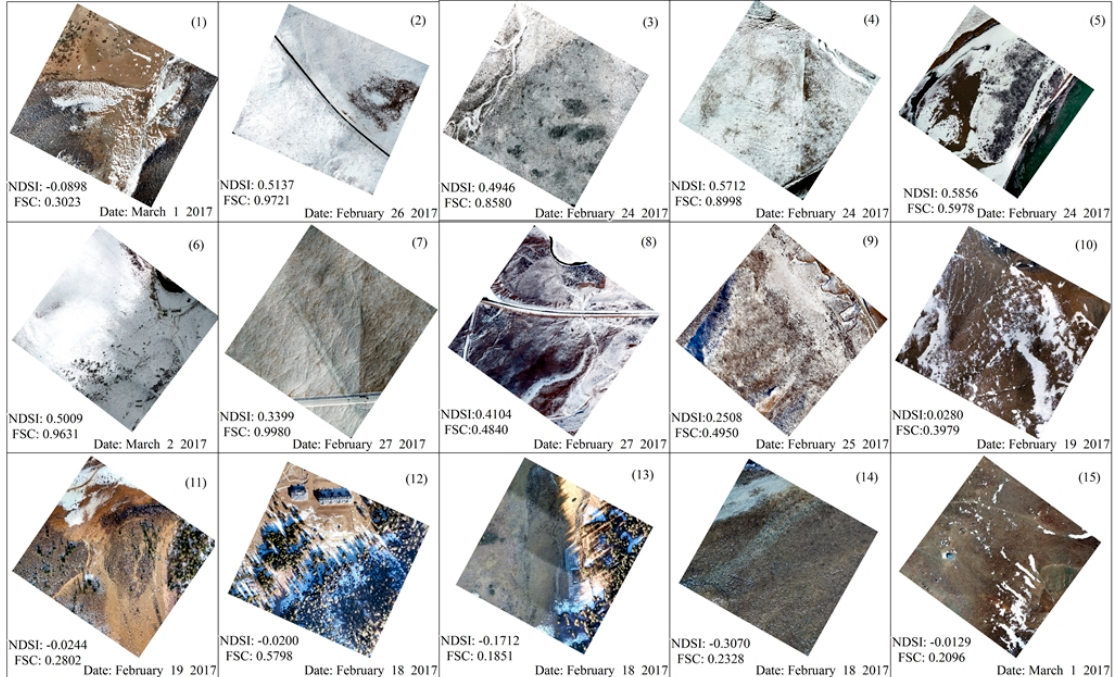
Figure 2. Fifteen fractional snow-cover sample maps from the UAV.